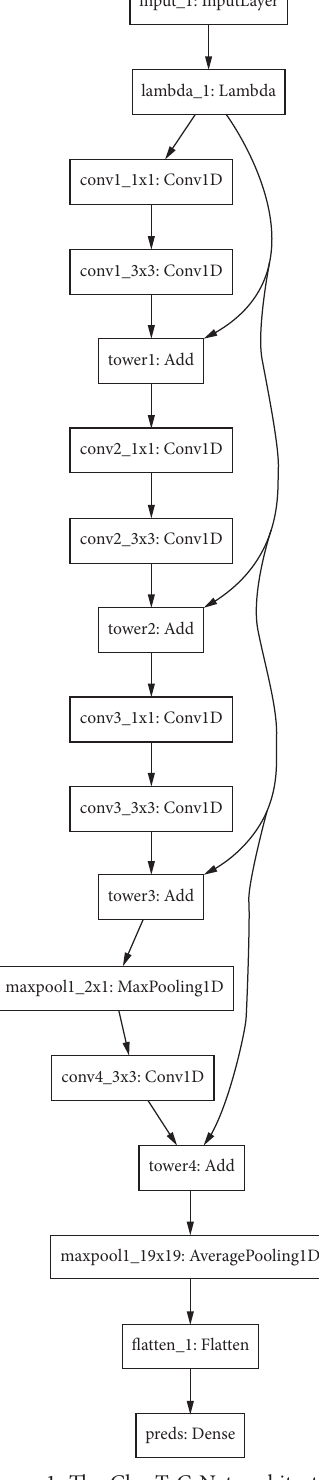
Figure 1: The CharTeC-Net